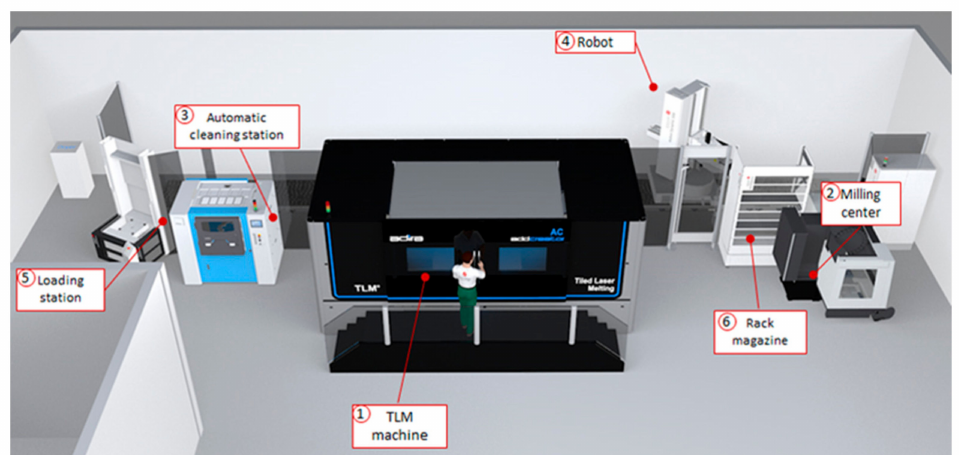
Figure 3. 3D layout of the POLY-SHAPE pilot cell overview. (1) TLM machine (ADIRA TLM AddCreator), (2) Milling centre (Haas 3-axis VF-2), (3) Cleaning station (SOLUKON AT800), (4) Robot (EROWA ERD 500), (5) Loading station (EROWA ERD 500), (6) Rack magazine (EROWA ERD 500). In the case of the SLM post-processing cell, the final layout is shown in Figure 4.